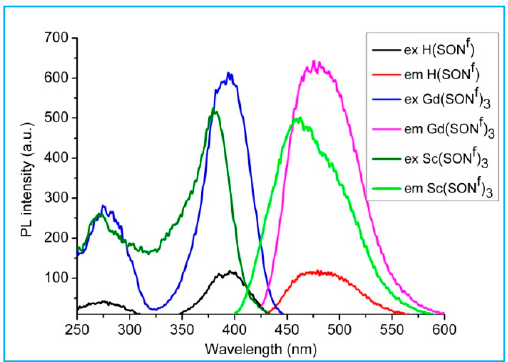
Figure 7. PL excitation and PL spectra of (benzothiazolyl)phenole H(SON F ) and complexes 1 and 2 ( λ exc = 395 nm) in a THF solution (10 − 5 M).